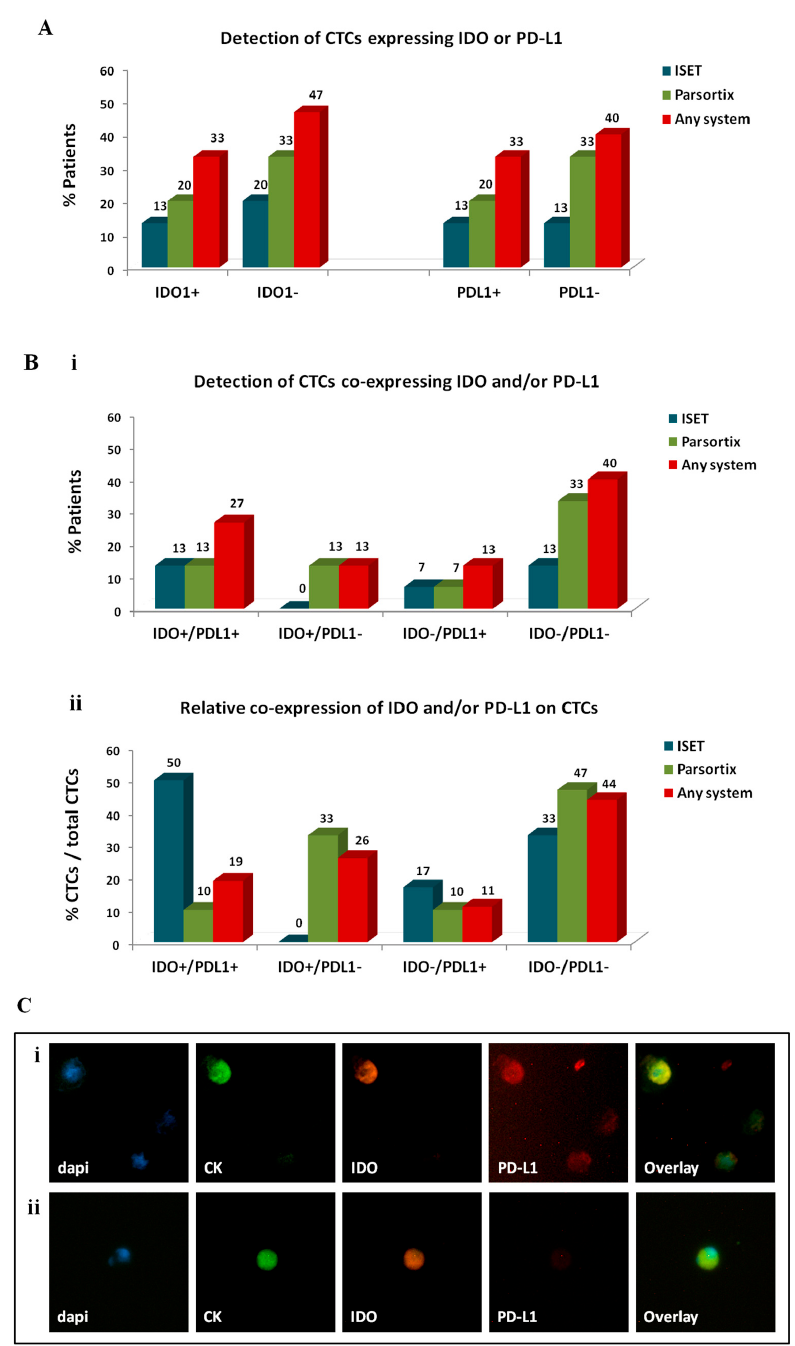
Figure 5. Expression of immune checkpoints, indoleamine-2,3-dioxygenase (IDO) and programmed cell death ligand-1 (PD-L1), on circulating tumor cells (CTCs) of patients with non-small cell lung cancer (NSCLC): Distribution of distinct CTC subsets enriched by different approaches. ( A ) Percentage of patients harbouring CTCs of distinct IDO or PD-L1 phenotypes and ( Bi ) percentage of patients harbouring CTCs of distinct IDO / PD-L1 co-expressing phenotypes. The detection of at least 1 CTC of a specific phenotype was used to define positivity for the respective phenotype. ( Bii ) Percentage of CTCs presenting distinct IDO / PD-L1 co-expressing phenotypes. Any method depicts the percentage of a specific phenotype among the total number of CTCs detected by all methods. Representative images of ( Ci ) IDO +/ PD-L1 + CTC and ( Cii ) IDO +/ PD-L1 − CTC, Ariol microscopy system, Genetix, New Milton, UK) (400 ×